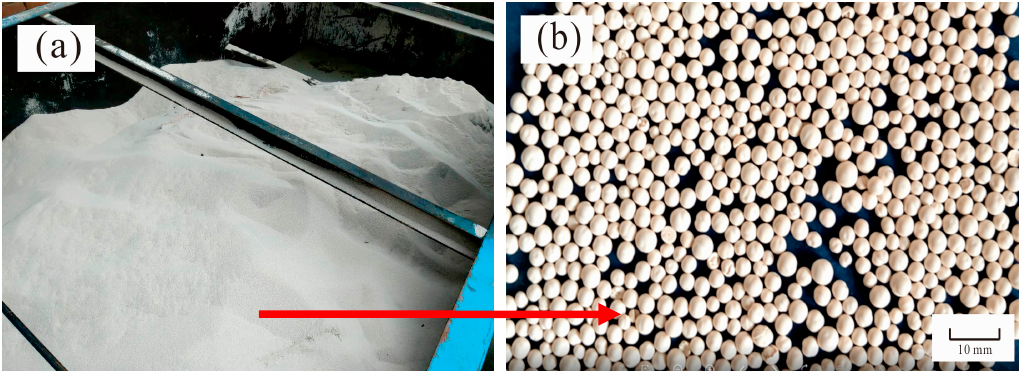
Figure 8. ( a ) Pellet storage box and ( b ) mature discharged pellets.